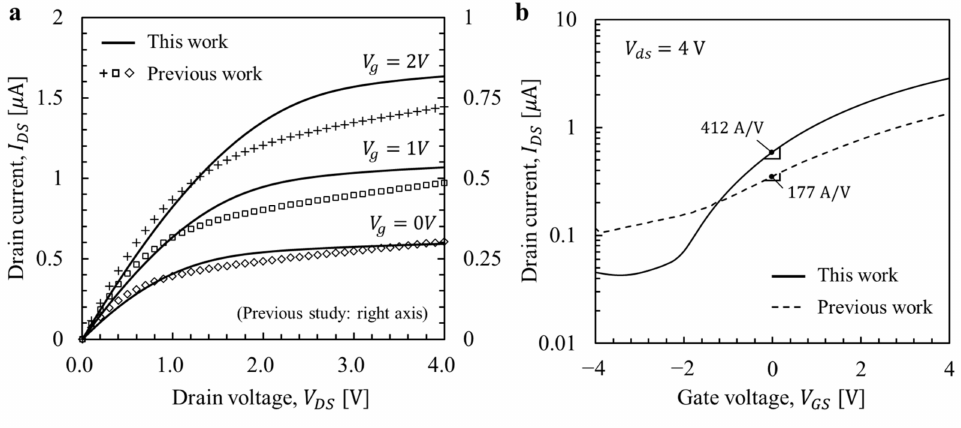
Figure 8. Comparison of I - V characteristics: ( a ) I DS - V DS curves, and ( b ) I DS - V GS curves.